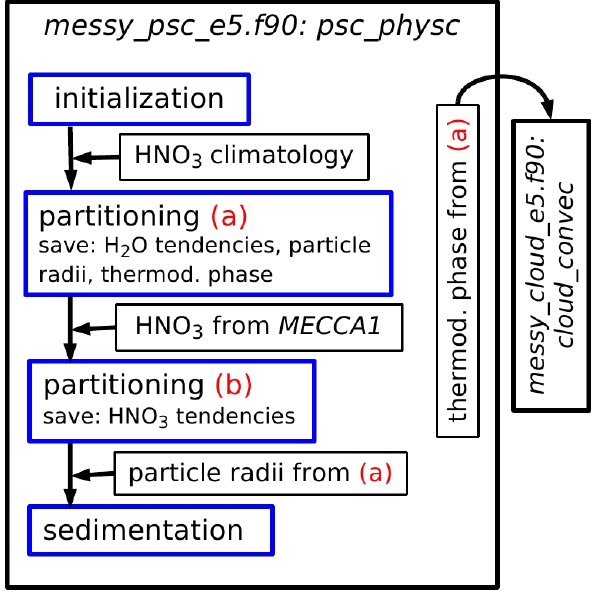
Fig. 3. Flowchart of how the QCTM is implemented into the EMAC submodel PSC. The partitioning is calculated twice using (a) offline, and (b) online mixing ratios of HNO 3 (see text for more detailed